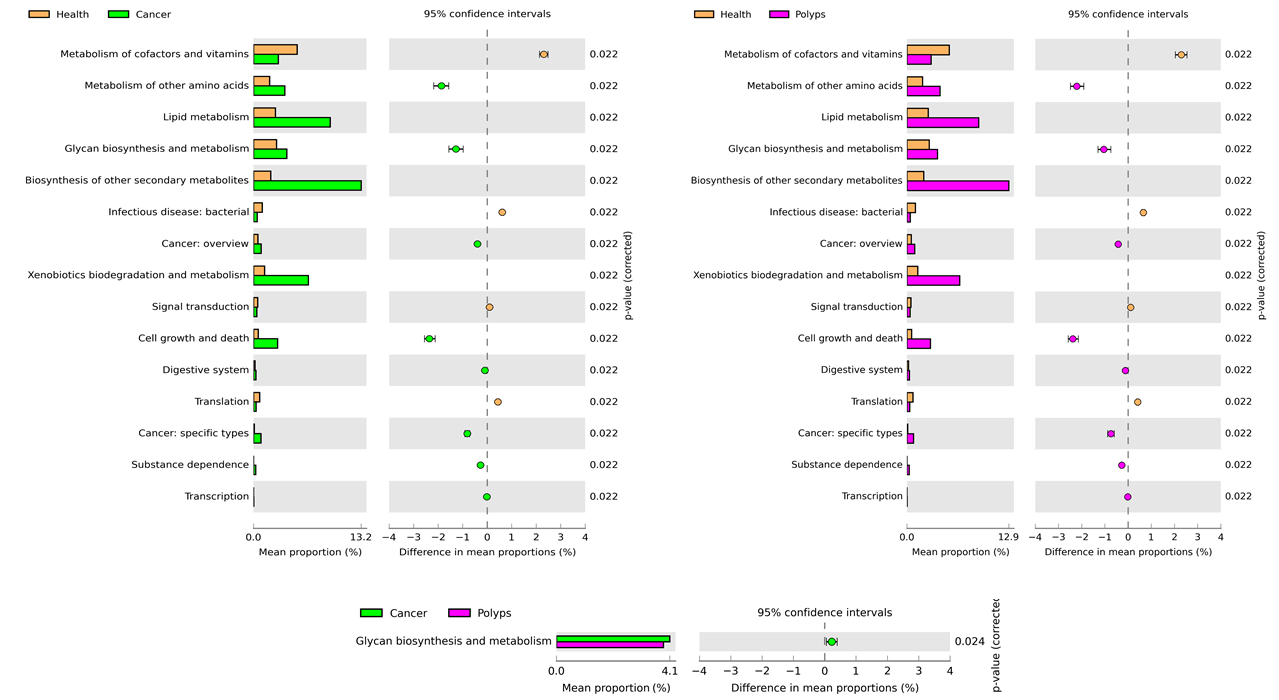
Figure 5. The post hoc plot of enriched microbial predicted functions among three health conditions (healthy, polyps, and cancer). The left side of these figures shows the abundance ratio of differentially enriched KEGG pathways. The right side represents the significant difference at p < 0.05, whereas the middle one indicates the mean proportion of differentially enriched KEGG pathways in the 95% confidence.